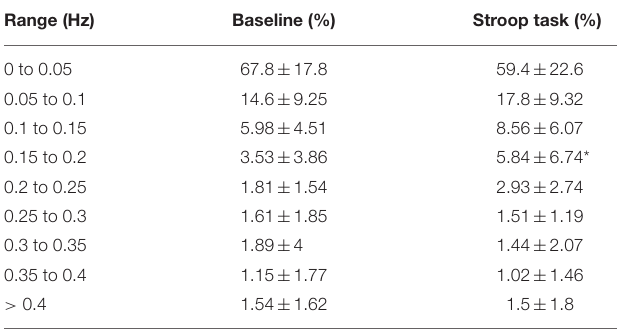
TABLE 1 | Percentage of time-invariant spectral power within the frequency bands of EDA for immersed subjects during baseline and Stroop task stages. Range (Hz)